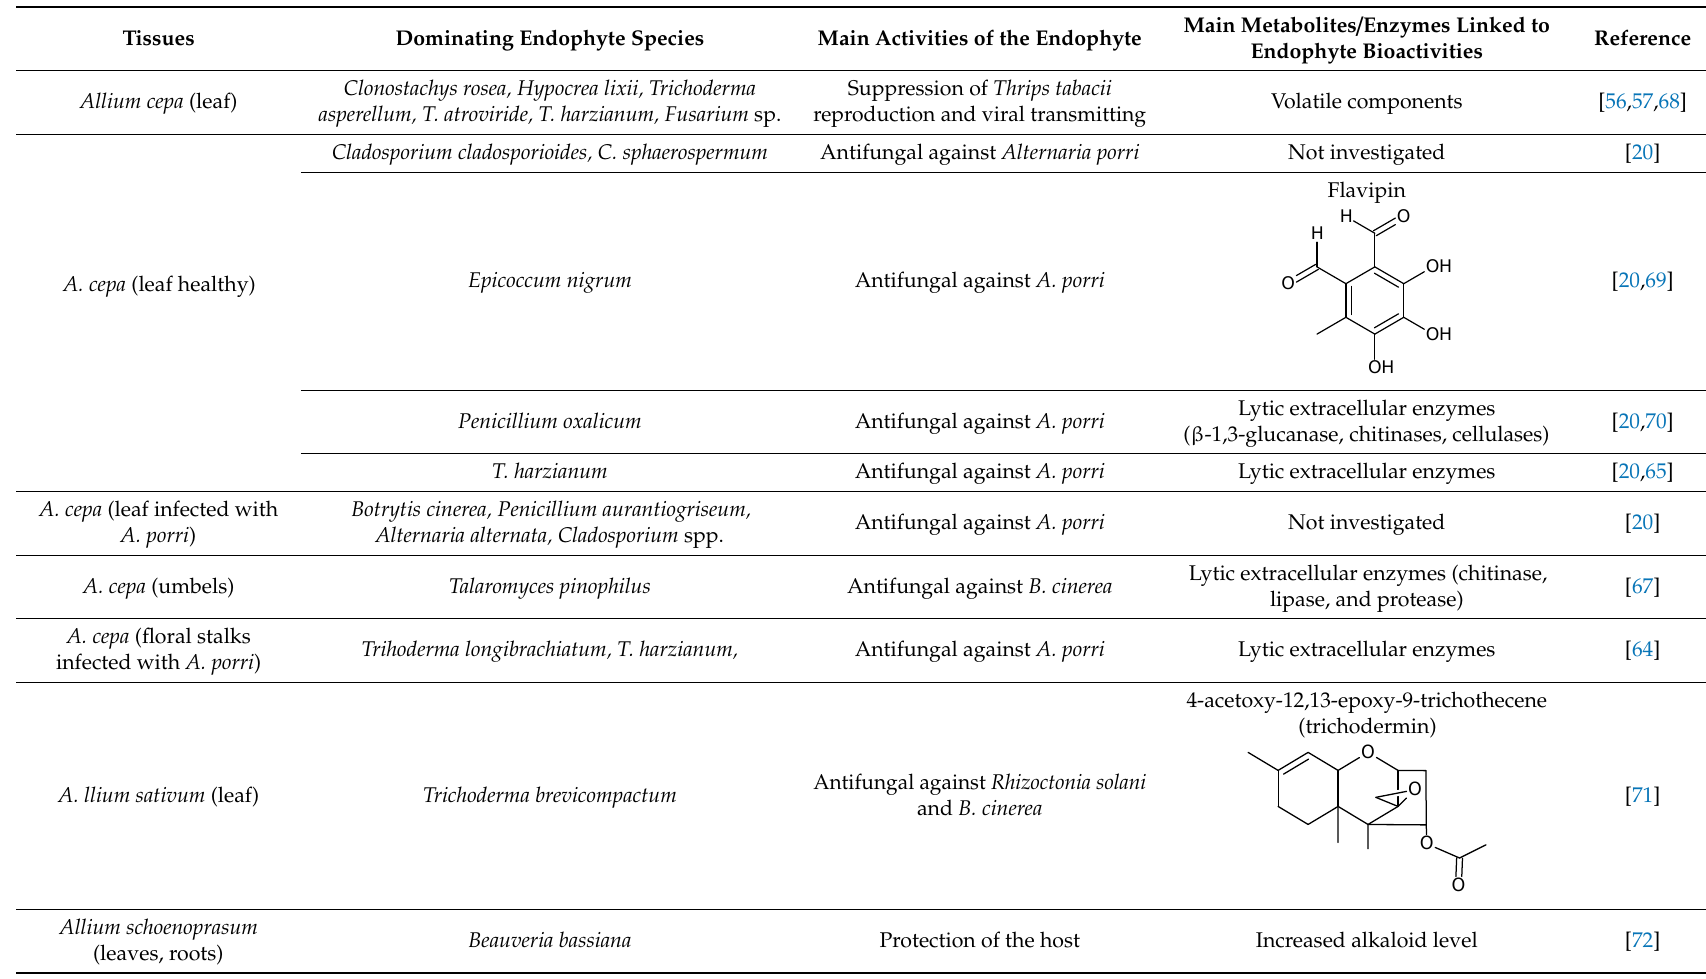
Table 1. Main biological activities of endophytes isolated from Allioidae crops.